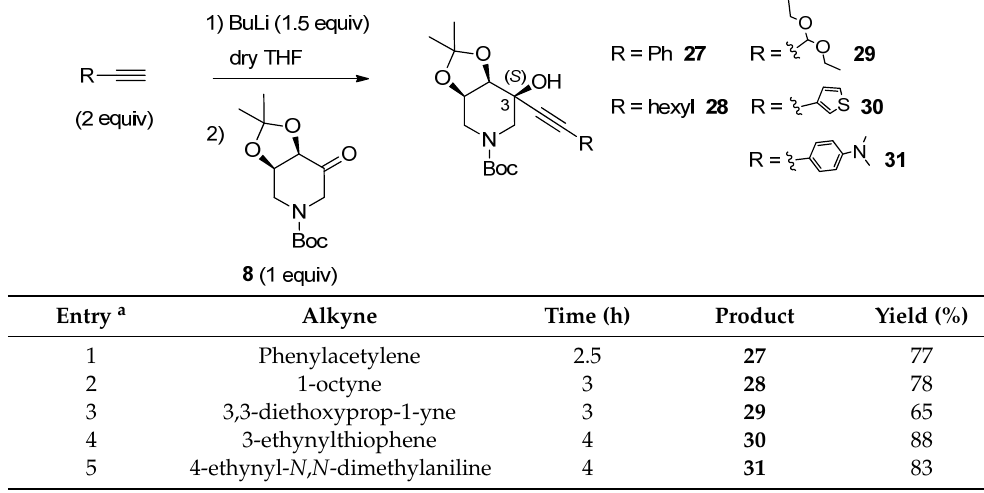
Table 1. Addition reactions of lithium acetylides to ketone 8 .